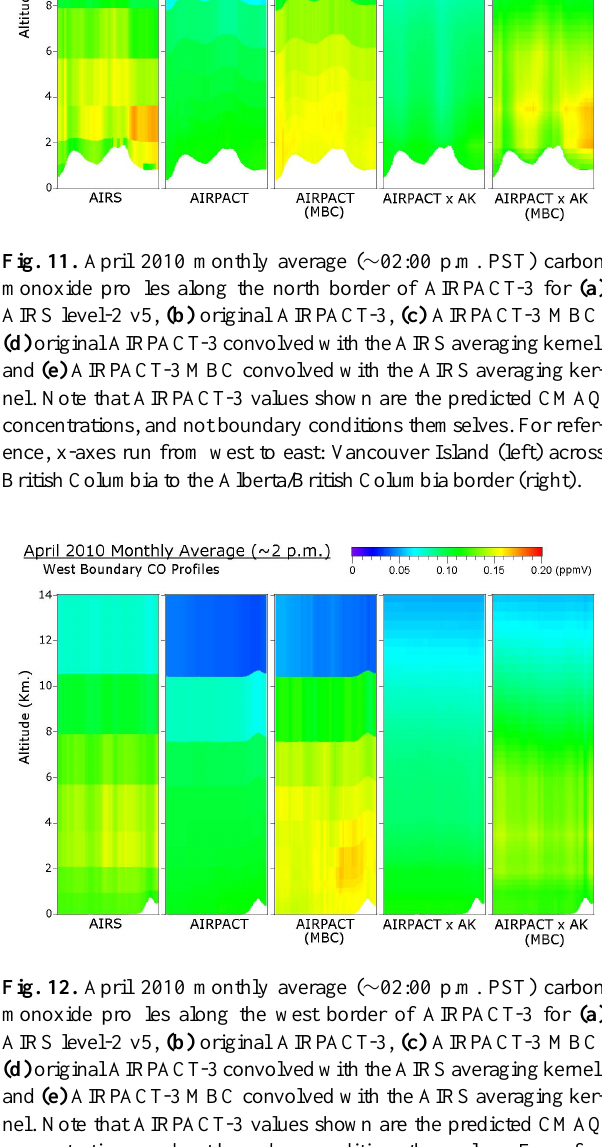
Fig. 14. AIRPACT-3’s predicted surface concentrations of ozone and AIRNOW measurements at five sites during peak ozone in Au- gust 2010. Blue lines denote AIRNOW, solid red lines denote the new AIRPACT-3 MBC simulations, and dotted red lines denote the original AIRPACT-3 simulations with static boundary conditions. All times are in Pacific Standard